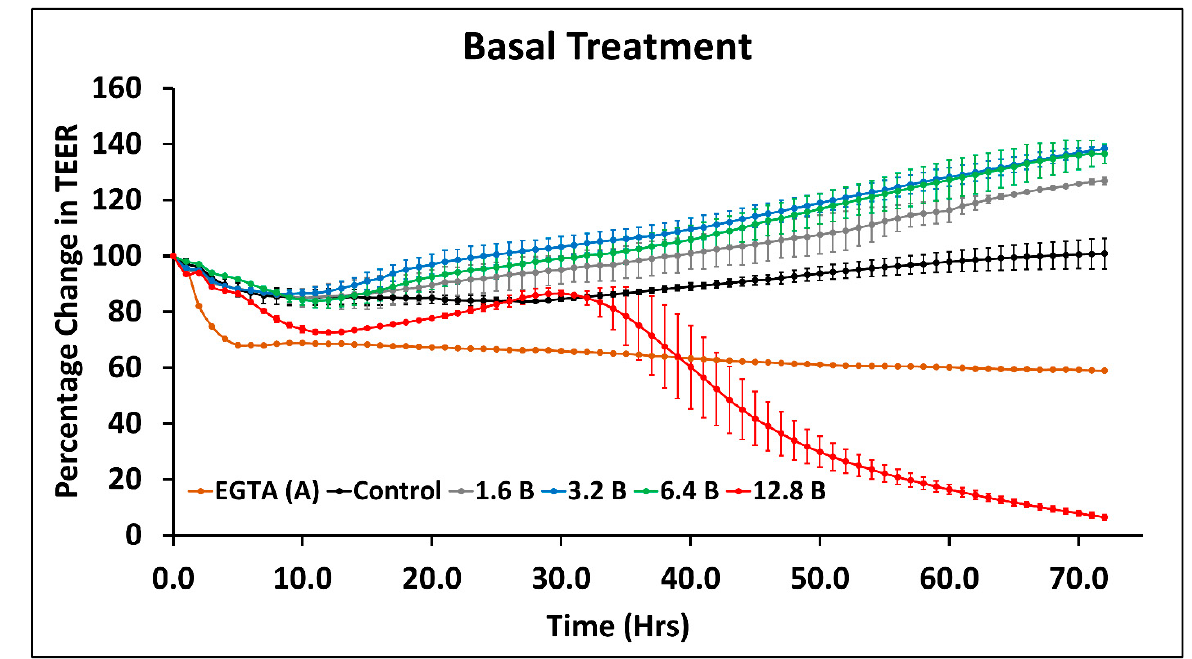
Figure 3. Change in TEER of T-84 cells monolayers during exposure to sodium arsenite from the basolateral side. B in legend denotes treatment from basolateral side with 1.6, 3.2, 6.4 and 12.8 µM concentrations. In addition, 2 mM of EGTA apical treatment was used as positive control. The graph represents the mean ± SD for each treatment group.